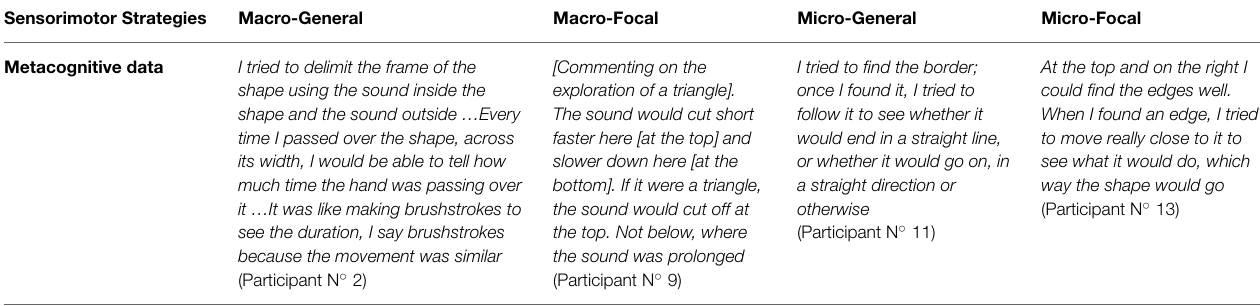
TABLE 6 | Metacognitive data of sensorimotor strategies in Experiment